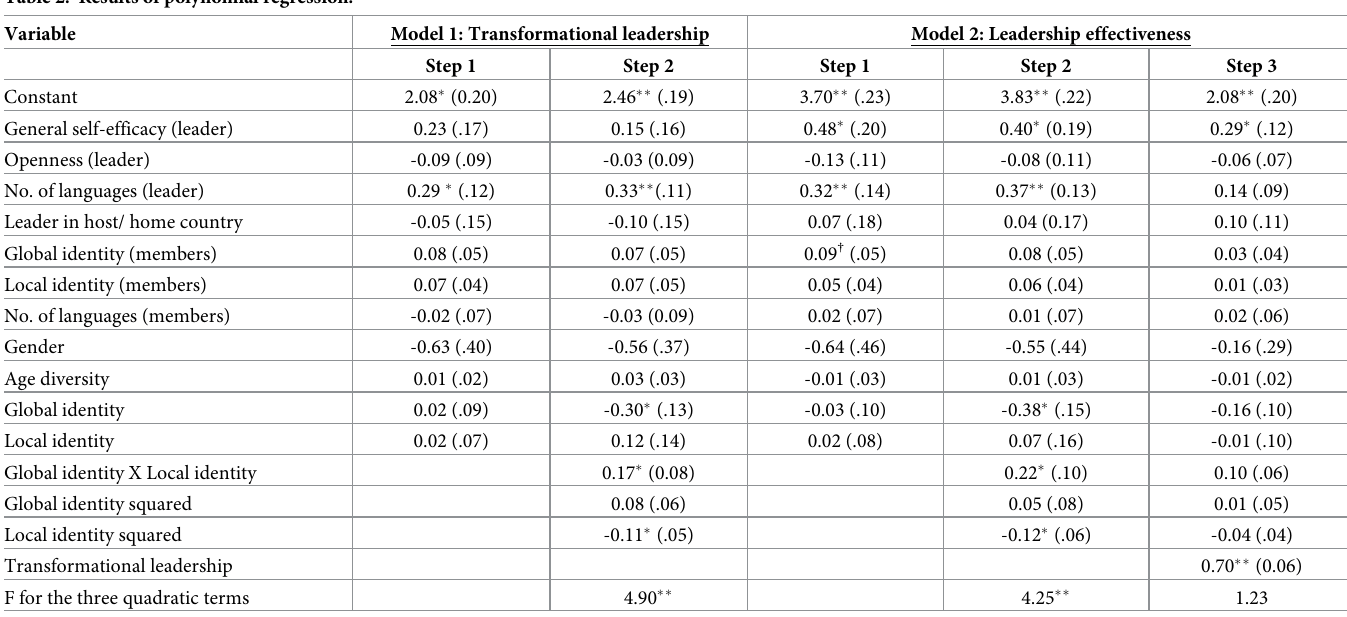
Table 2. Results of polynomial